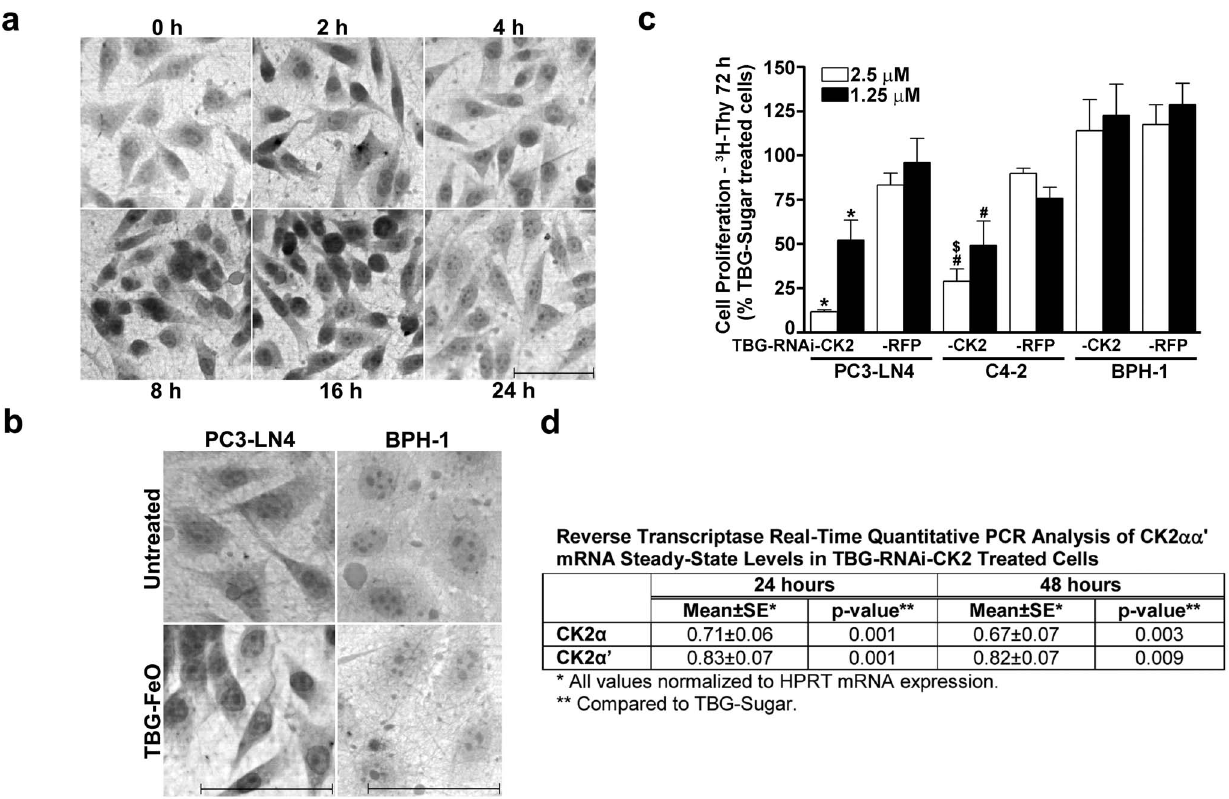
Figure 3. Cellular uptake of s50-TBG nanocapsules and effects of s50-TBG-RNAi-CK2 in benign and malignant prostate cells. ( a ) Uptake over 24 h of s50-TBG nanocapsules with FeO-dextran cargo in PC3-LN4 cells plated onto TnFn-3D. Cells were stained with DAB-enhanced Prussian blue for iron and counterstained with Fast Red. Scale bar 100 m m. ( b ) Malignant cell-specific uptake of s50-TBG nanocapsules. s50-TBG-FeO- dextran uptake was determined by iron staining at 8 h in PC3-LN4 and BPH-1 cells grown on TnFn- or laminin-coated nanofiber scaffolds, respectively. Scale bar 100 m m. ( c ) Cellular proliferation effects of s50-TBG-RNAi-CK2 treatment in benign and malignant prostate cells. PC3-LN4 and C4-2 grown on TnFn-3D and BPH-1 cells grown on laminin-3D in 96-well plates were treated with s50-TBG-RNAi-CK2 or control TBG nanocapsules containing RNAi-RFP-6R targeting Red Fluorescence Protein as indicated. 3 H-thymidine was added after 48 h, and cells analyzed at 72 h post- nanocapsule addition. Results are expressed relative to treatment with s50-TBG-sugar nanocapsules. The s50-TBG nanocapsule cargo and cell lines used are indicated below the bars. Means 6 SE are presented (n=3 for all). *p , 0.005 relative to s50-TBG-sugar and –RFP; # p , 0.01 relative to TBG- sugar; $ p=0.006 relative to TBG-RFP. ( d ) s50-TBG-RNAi-CK2 treatment reduced CK2 a and CK2 a ’ mRNA steady-state expression levels in PC3-LN4 cells. mRNA isolated from PC3-LN4 cells grown on TnFn 24 and 48 h after s50-TBG-RNAi-CK2 or –sugar treatment as indicated was analyzed by reverse transcriptase real-time quantitative PCR for CK2 a and CK2 a ’ expression. HPRT transcript was used to normalize expression levels. Means, SE and p-values are presented (24 h CK2 a n=5, CK2 a ’ n=6; 48 h CK2 a n=2, CK2 a ’ n=2).